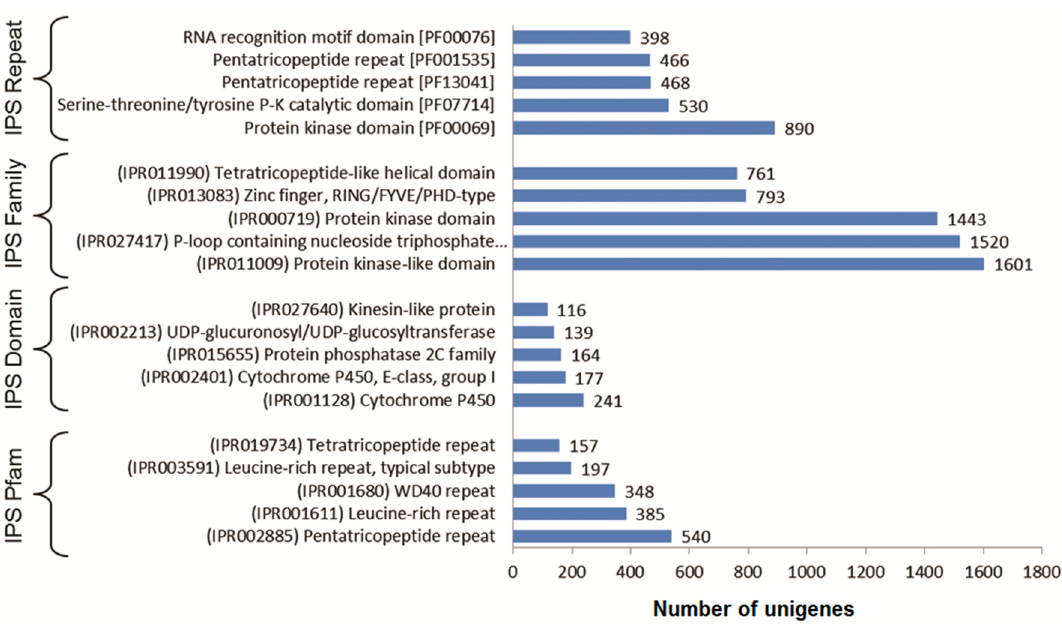
Figure 3. Result showing top 5 hits against interproscan repeat, family, domain and Pfam database.